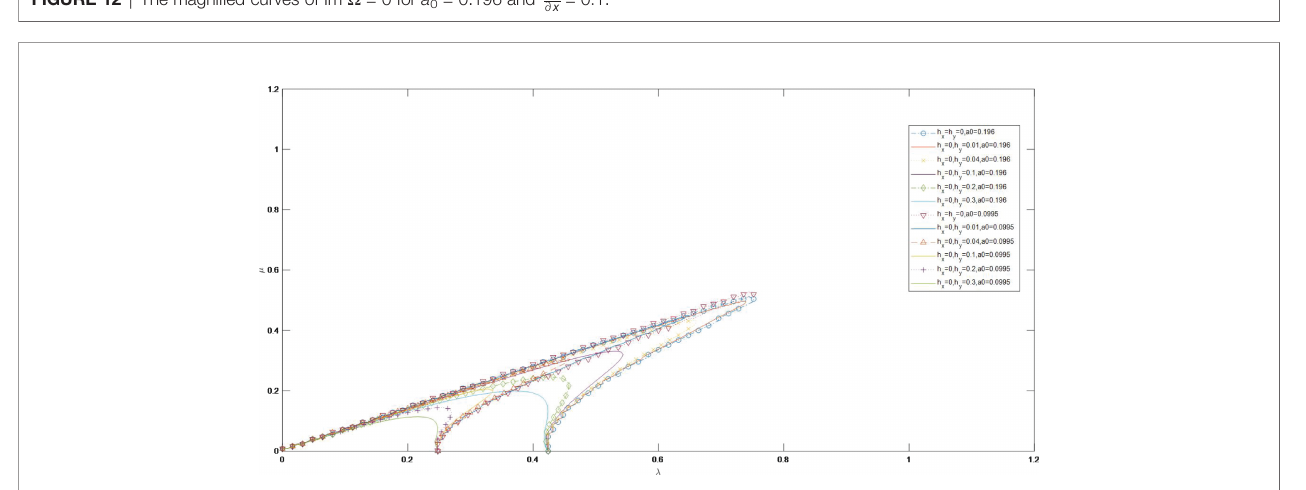
FIGURE 13 | Curves of Im W = 0 for a 0 = 0.0995 and a 0 = 0.196 as ∂ h ∂ x =